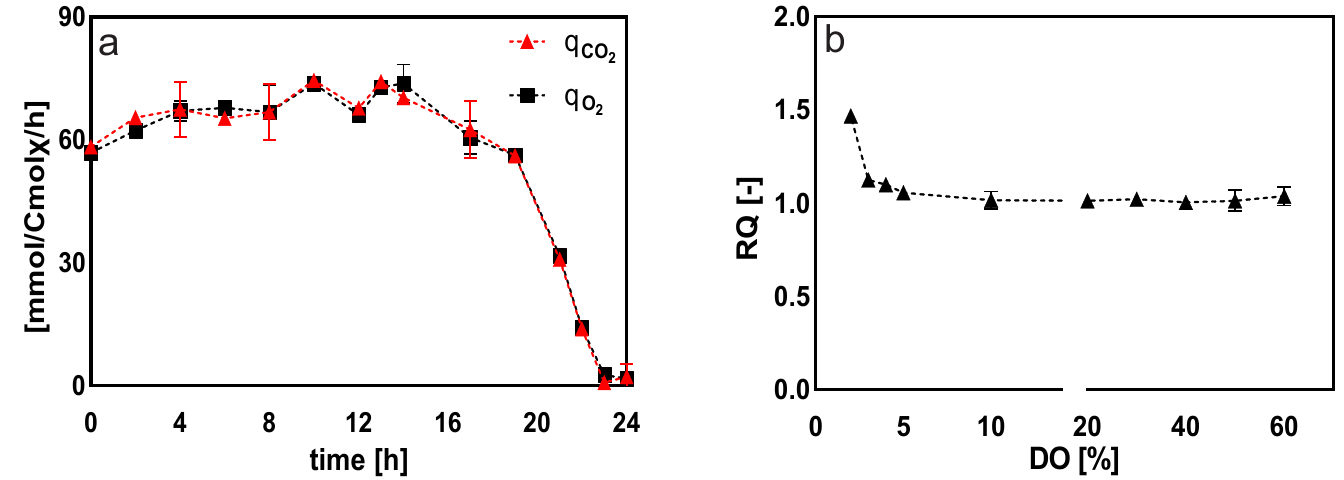
Figure 11. ( a ) Changes in the respiratory intensity of the cell at DO-ramp experiments. The dissolved oxygen was linearly decreased from 60% to 0% in 24 h. Time 0 represents the startup of DO ramp- down; ( b ) Respiratory quotient of Penicillium chrysogenum Wisconsin 54-1255 at different dissolved oxygen levels calculated from DO shift and ramp